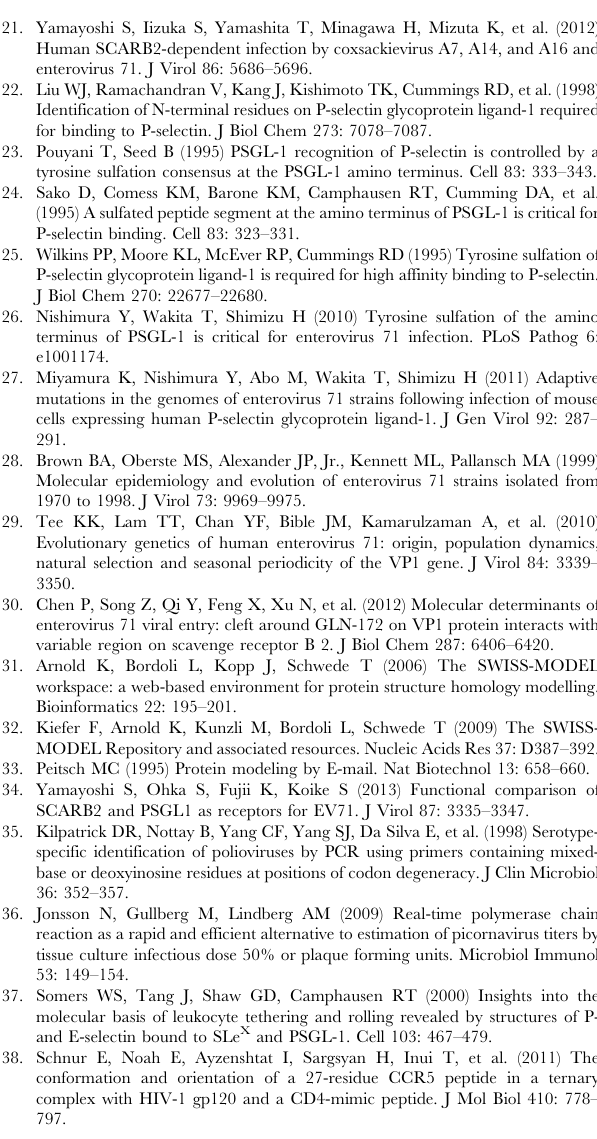
Table S2 Primers for PCR amplification of EV71 genomes. Table S3 Primers for